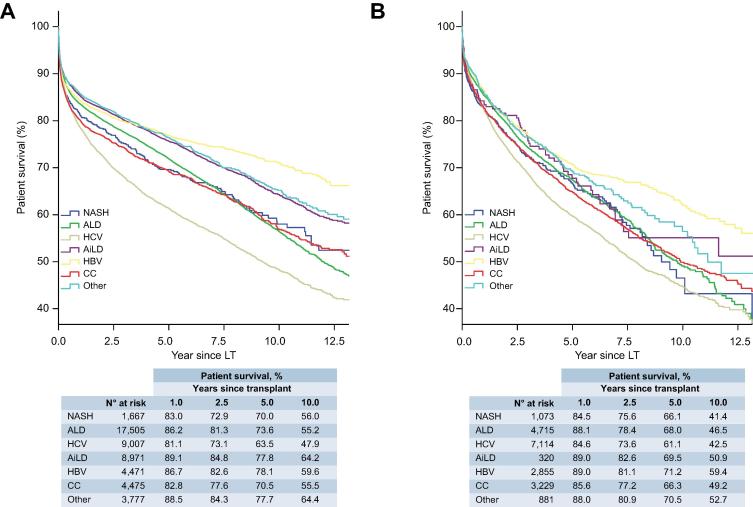
Overall allograft survival analysis for patients undergoing primary liver transplantation for different indications. Kaplan-Meier curves of overall allograft survival for cases without (A), and with HCC (B) (log-rank: p <0.001 for both). AiLD, autoimmune liver disease; ALD, alcohol-related liver disease; CC, cryptogenic cirrhosis; HBV, hepatitis B virus infection; HCV, hepatitis C virus infection; LT, liver transplant; NASH, non-alcoholic steatohepatitis. (This figure appears in colour on the web.)